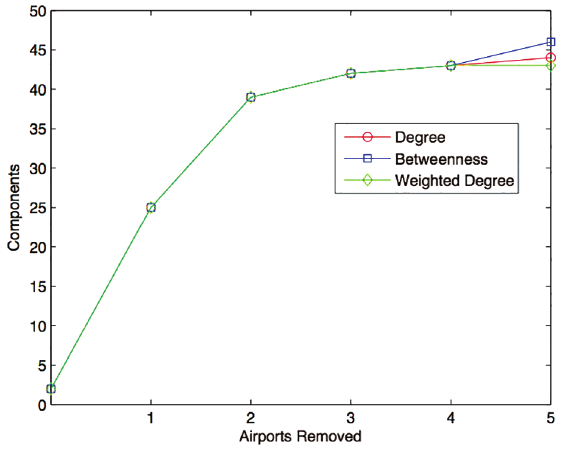
Figure 10 - Changes on the percentage of passengers by the total number of removed airports. For interpretation of the references to color in this figure, the reader is referred to the web version of this